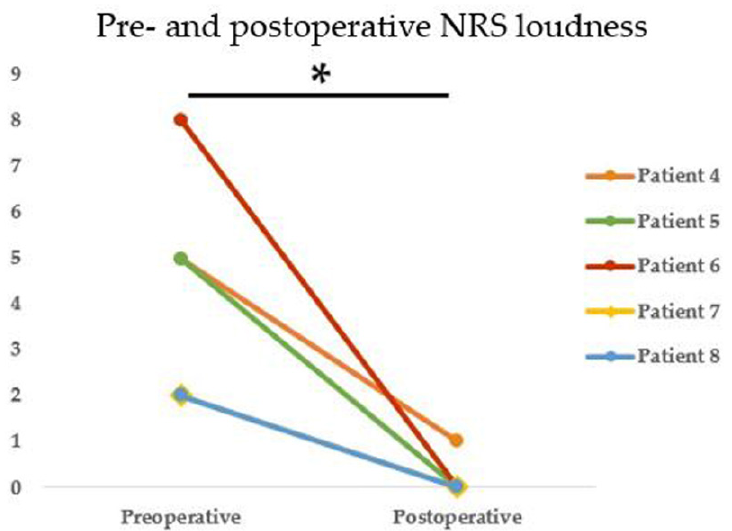
Figure 4. Pre- and postoperative NRS loudness scores indicated significant, marked improvements after surgery in all five patients (subjects 4, 5, 6, 7, and 8) ( p = 0.042, * Indicates statistical significance by the Wilcoxon signed-ranks test).